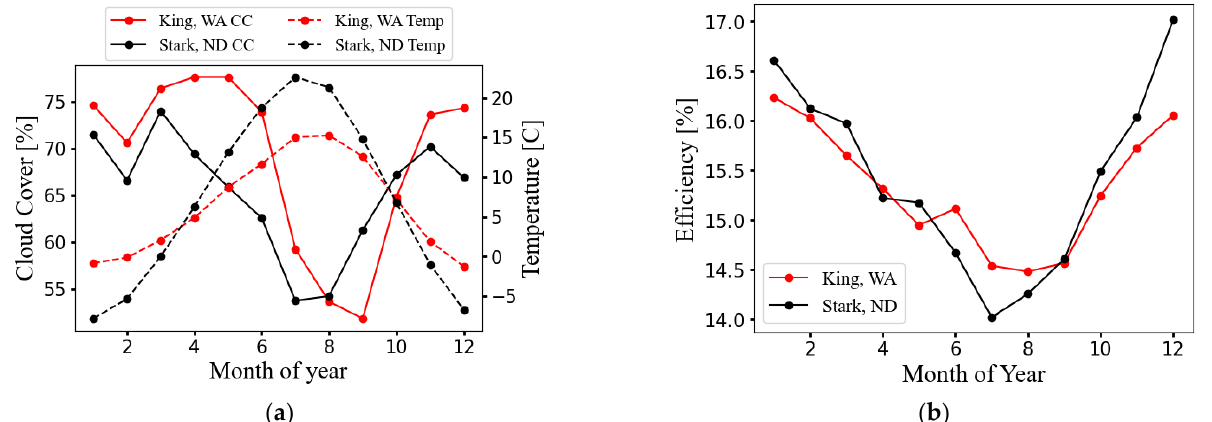
Figure 8. ( a ) Comparison of seasonal cloud cover and ambient temperatures for case 1 indicated in Figure 5. ( b ) The temperature-dependent efficiency of PV panels for case 1 locations.